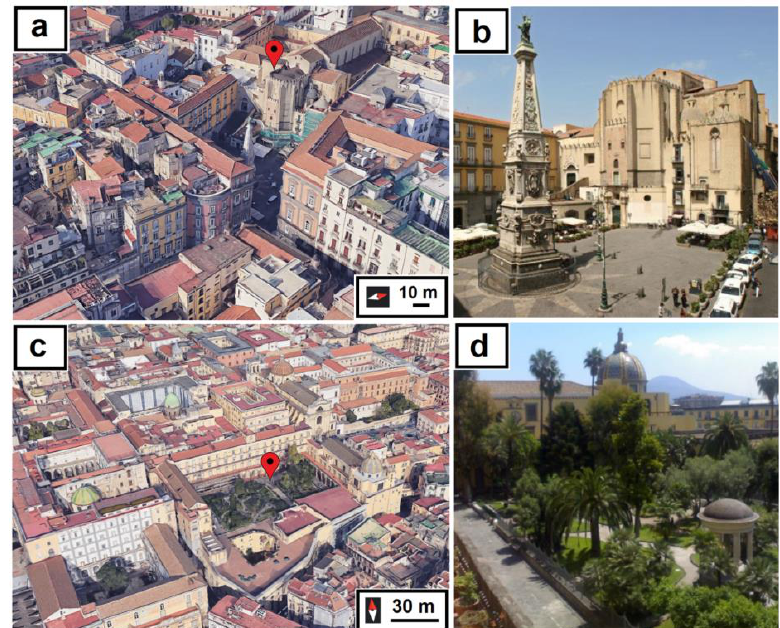
Figure 1. Complex of San Domenico Maggiore (40°50′55′’N; 14°15′16′’E) and cloister of San Marcellino e Festo (Naples, Italy) (40°50′49′’N; 14°15′28′’E): ( a,c ) Aerial view of the two monumental complexes by Google Earth; ( b ) view of the San Domenico Maggiore church with the apse facing the eponymous square; ( d ) General view of the Cloister and San Marcellino e Festo church with evidence of the tiled dome .